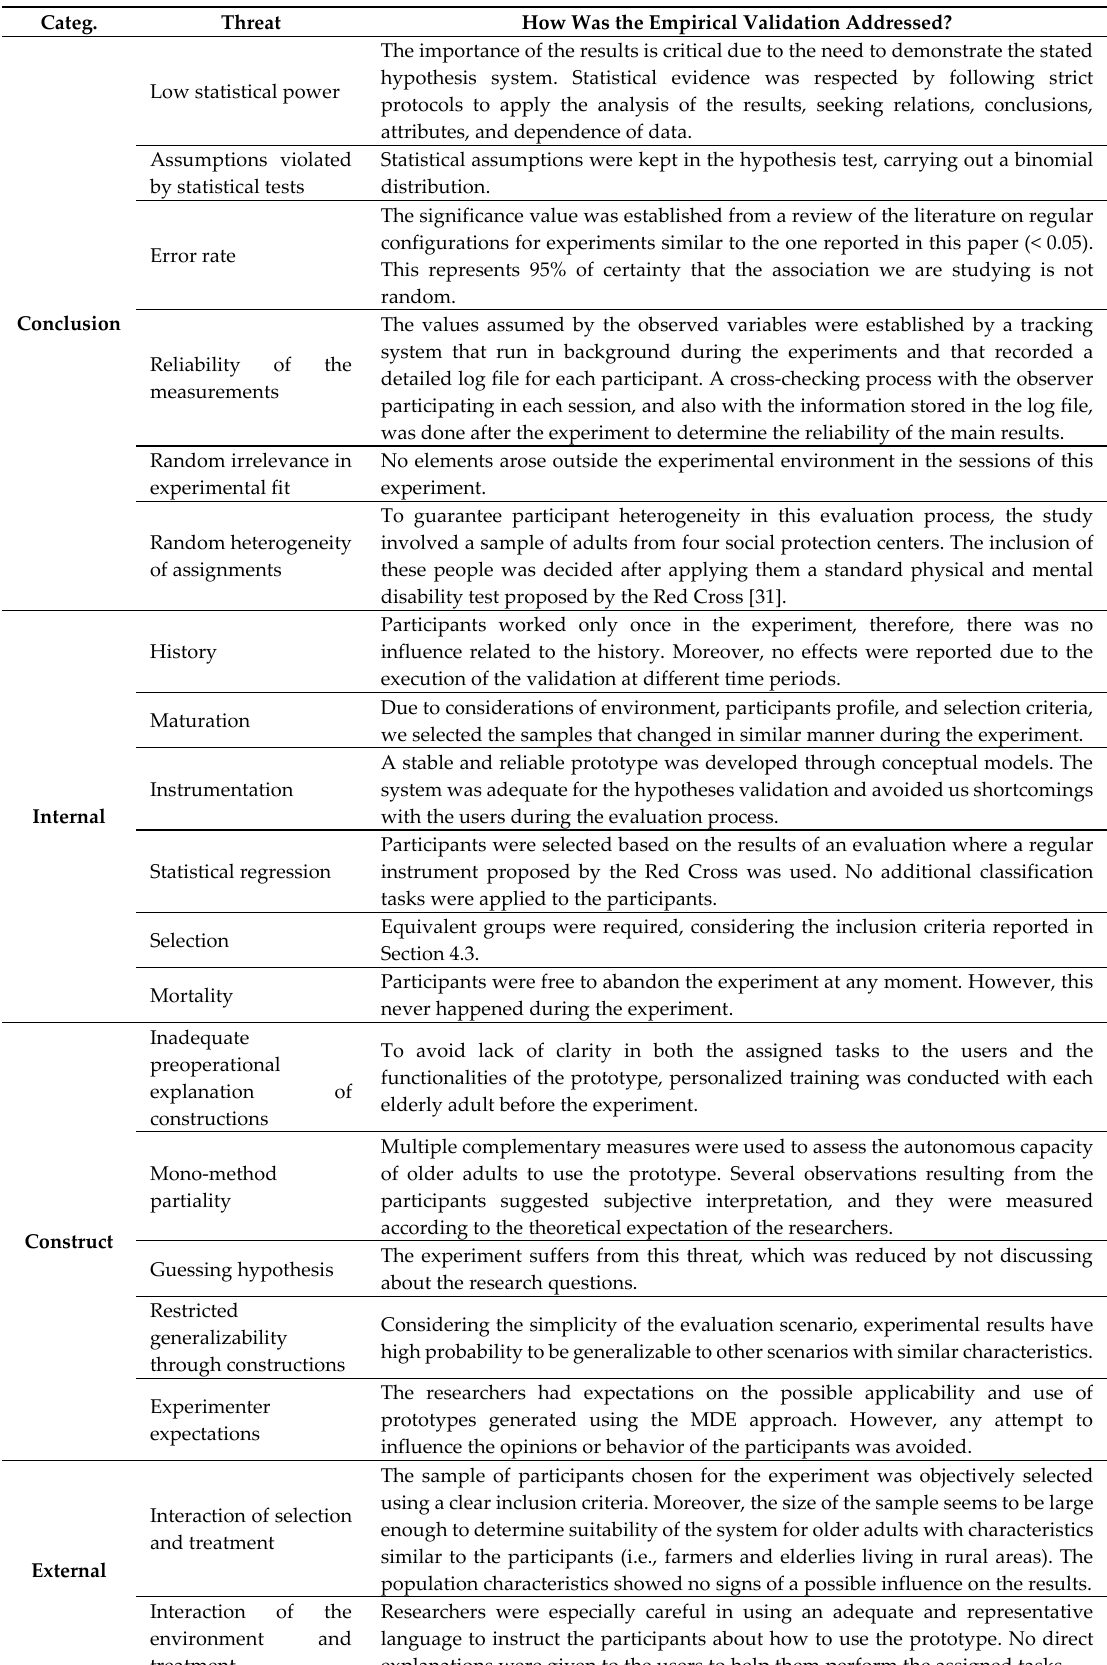
Table 5. Analysis of threats to the validity of the experiment.